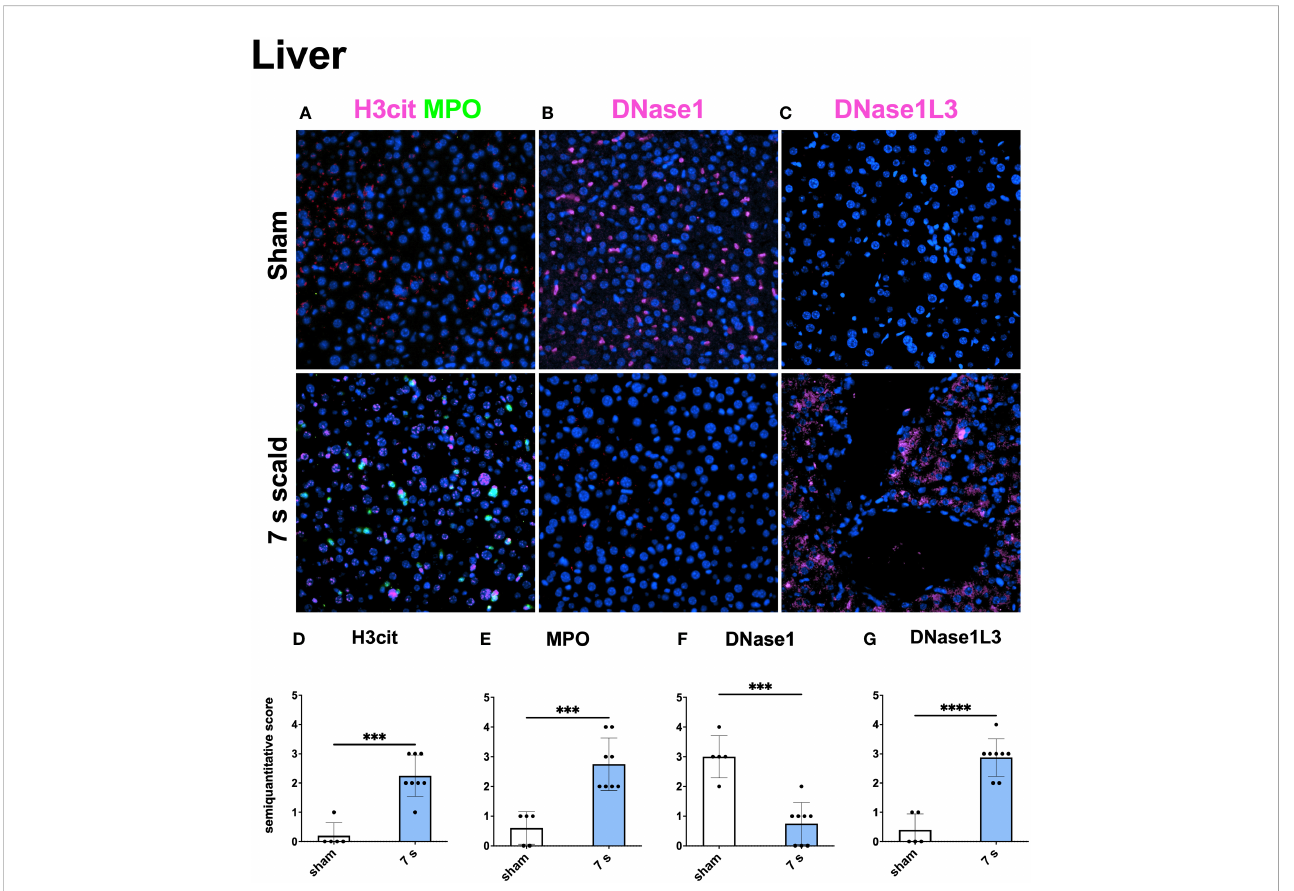
FIGURE 11 7 s scald leads to an upregulation of NETosis and DNase1L3, and a downregulation of DNase1 in the immuno fl uorescence staining of the Liver. Representative merge images of immuno fl uorescence staining of the liver for H3cit/MPO (A) , DNase1 (B) , and DNase1L3 (C) are displayed. DNA counterstain was performed with DAPI (blue). Magni fi cation level 40x. Semiquantitative scores were used to estimate the amount of H3cit (D) , MPO (E) , DNase1 (F) , and DNase1L3 (G) . Results are provided as mean ± SD. For comparison, an unpaired t -test was performed. The levels of signi fi cance: ***p < 0.001; ****p <